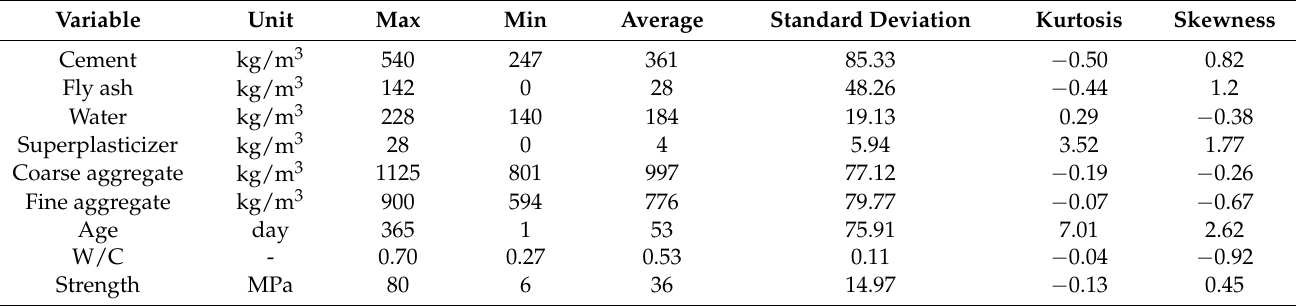
Table 2. Equations of the evaluation indices. Evaluation Metrics